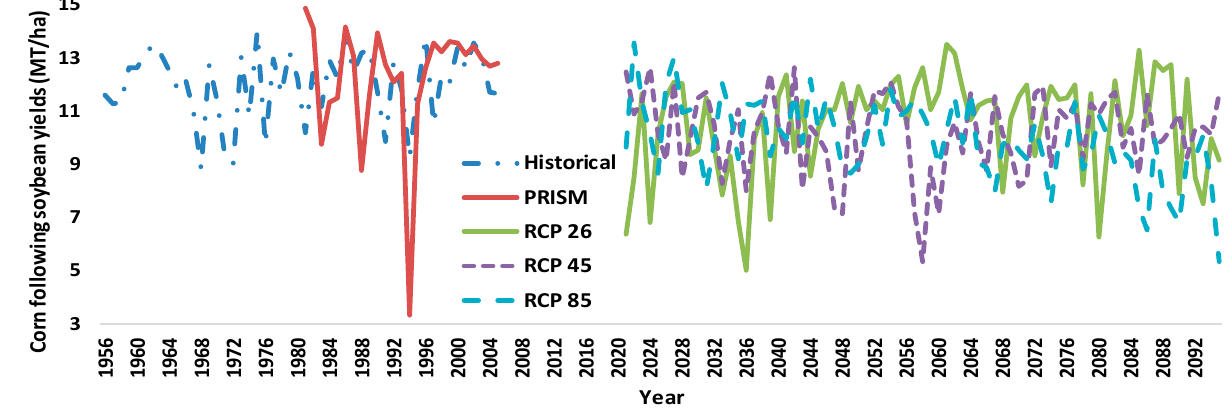
Figure 5. Graph of annual simulated corn following soybean yields by climate scenario.